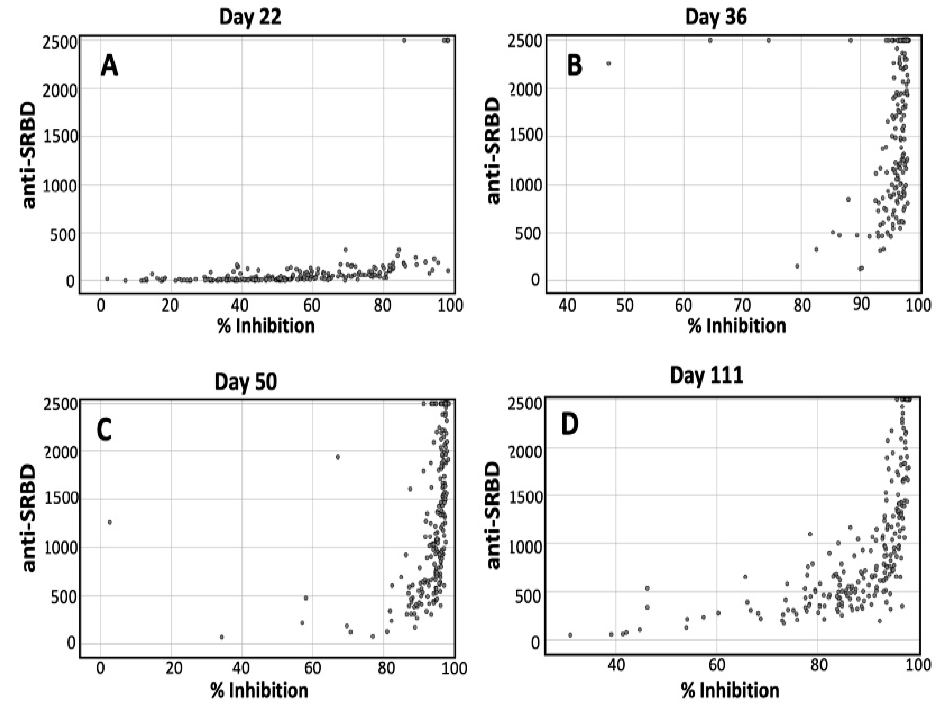
Figure 3. Relationship between the inhibition (%) of SARS-CoV-2 binding to the human host re- ceptor angiotensin-converting enzyme-2 and the Spike-receptor binding domain antibodies (an- ti-SRBD) at four different occasions (days). ( A ) Day 22, ( B ) Day 36, ( C ) Day 50, ( D ) Day